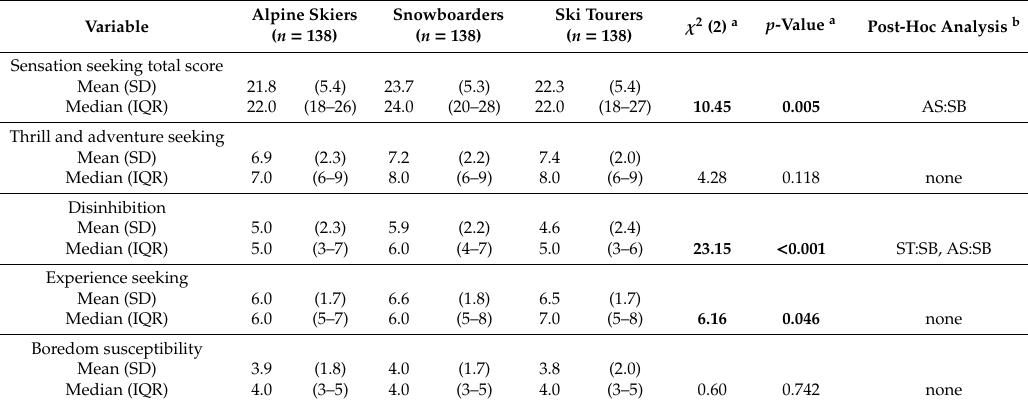
Table 2. Sensation seeking separately for ski tourers, alpine skiers, and snowboarders. Variable Sensation seeking total score Mean (SD)